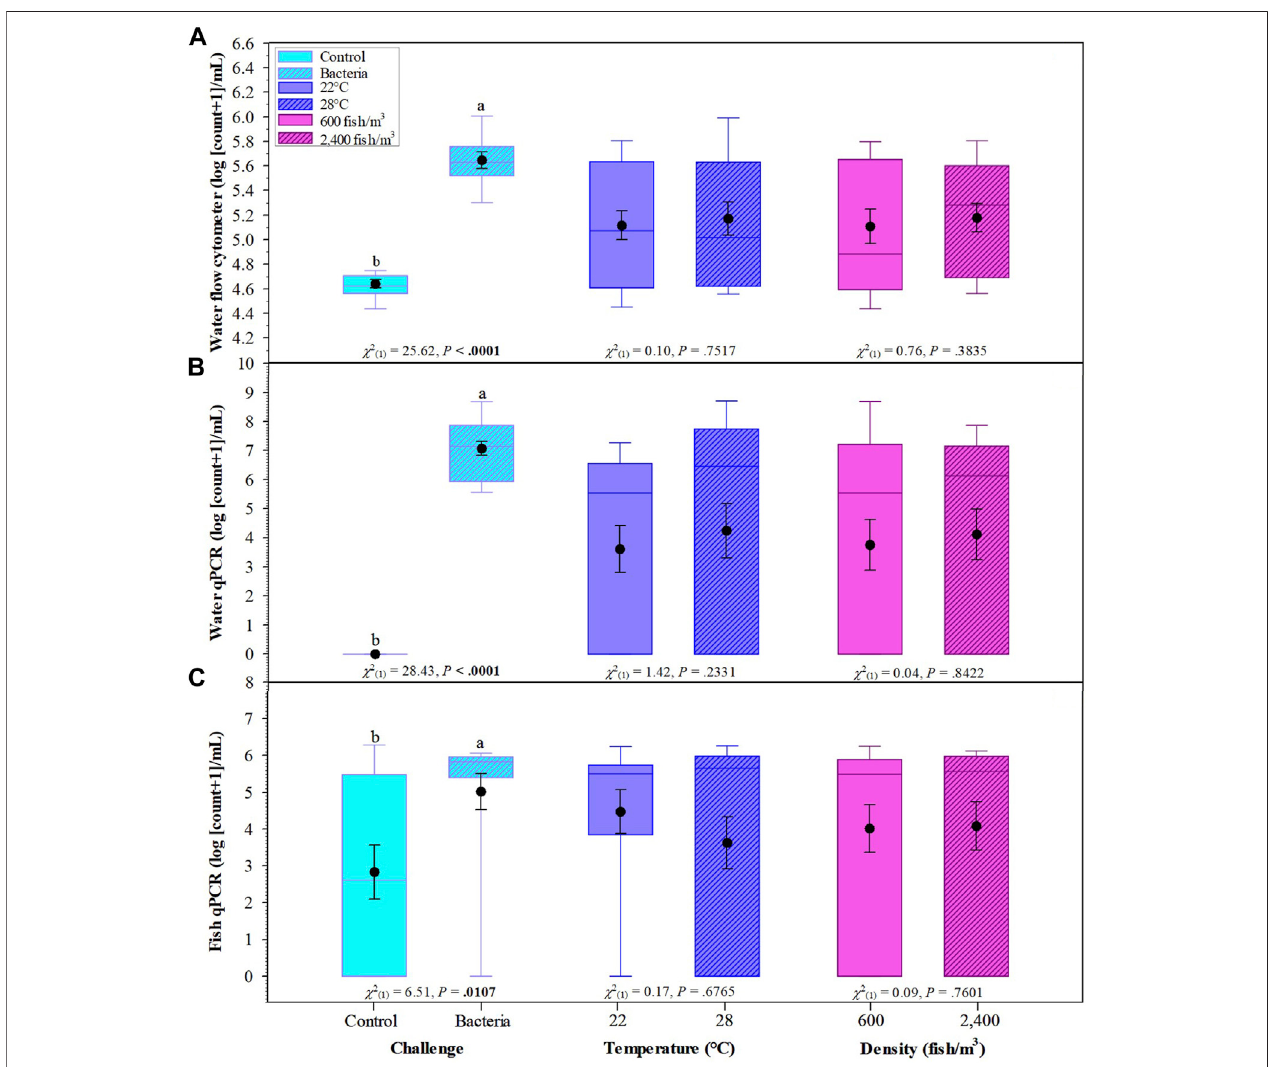
FIGURE 5 | Effects of challenge, temperatures, and fi sh density of Golden Shiners on fl ow cytometer bacterial count in water (A) , water qPCR (B) , and fi sh qPCR (C) . Golden Shiners were subjected to low (600 fi sh/m 3 ) or high (2,400 fi sh/m 3 ) densities at low (22 ° C) or high (28 ° C) temperature treatments. Treatments included challenge with F. covae (Bacteria) or no exposure to F. covae (Control). Within each box plot, vertical line indicates the median, black dot indicates the mean, and error bars around the black dot represent standard error of the mean. Data with different lowercase letters within same variable differ signi fi cantly at p < 0.05 if bold .